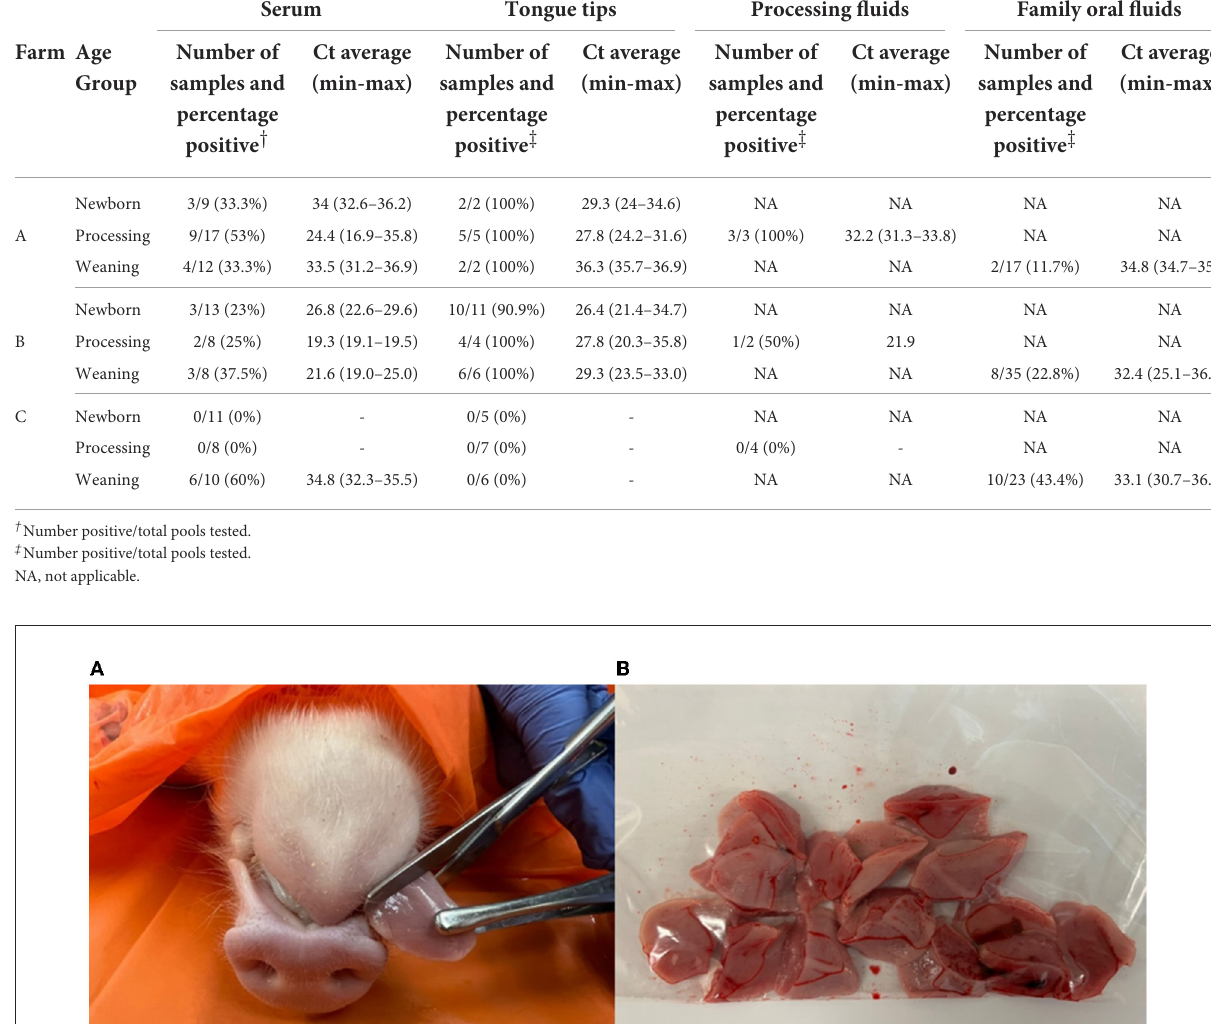
dividing the number of positive samples by the total number of collected samples per specimen for each age group and